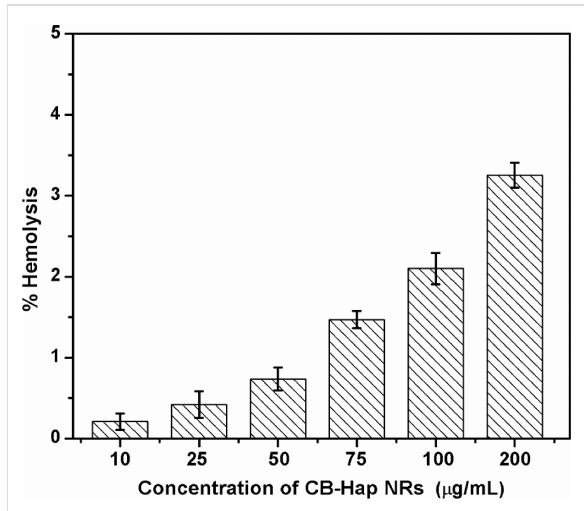
Figure 5: Hemolytic behavior of hydroxyapatite (Hap) nanorods using cuttlefish bone powder as a precursor (CB-Hap NRs) at various con-